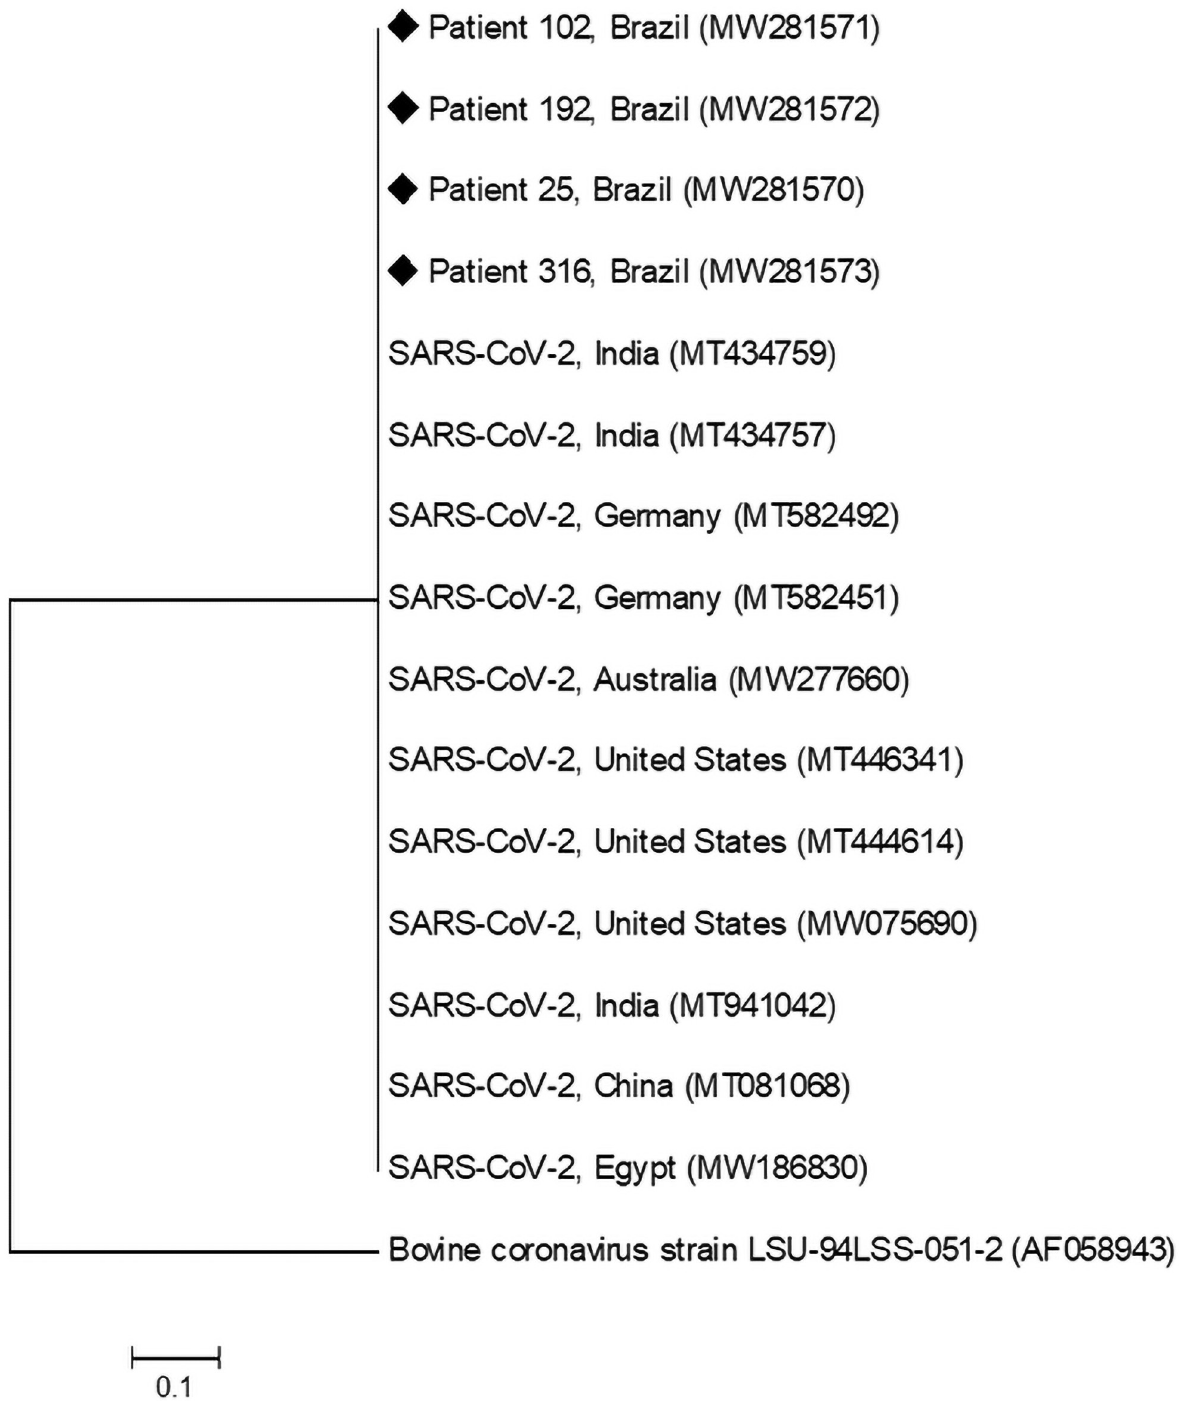
Fig 1. Phylogenetic tree of N gene sequences from SARS-CoV-2 isolated in several countries and Brazil ( ♦ ).